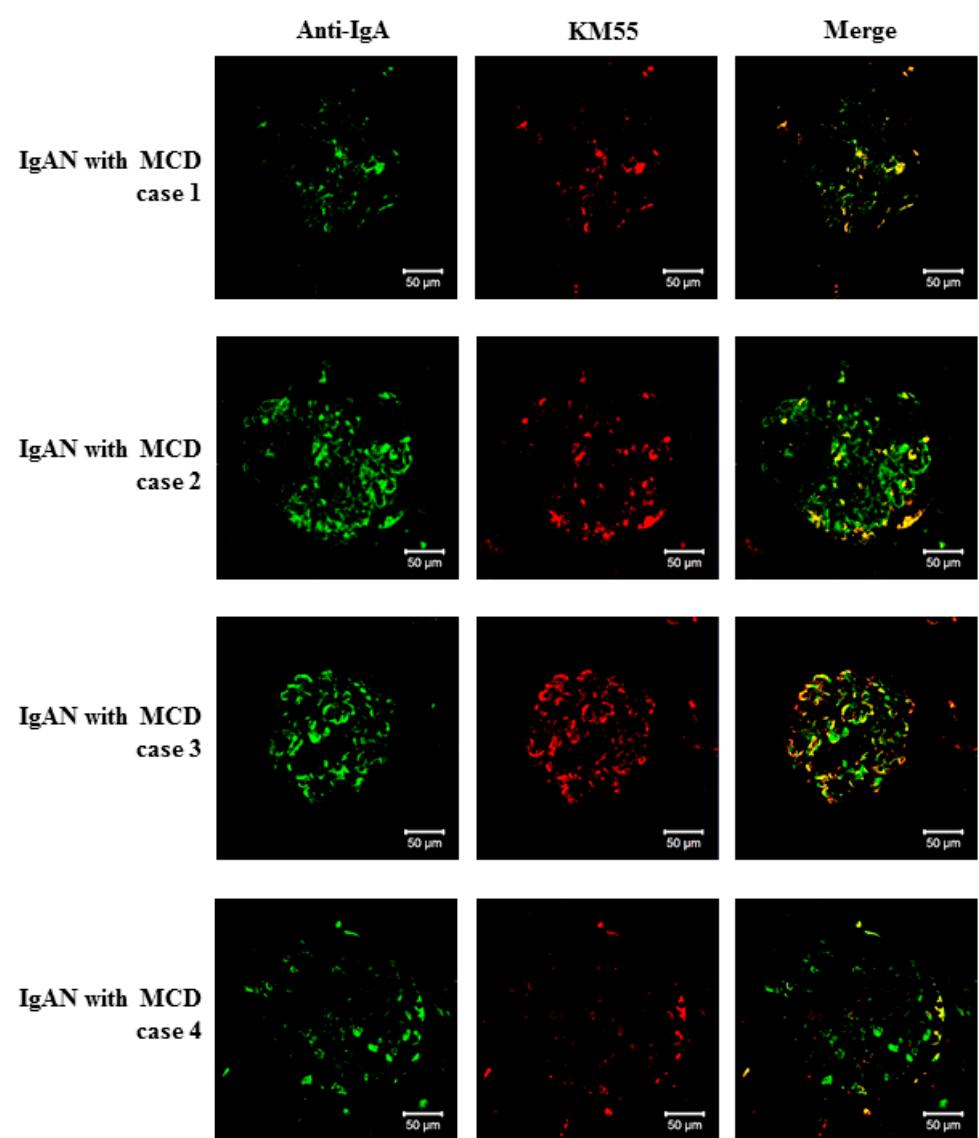
Figure 3. Glomerular deposition of galactose-deficient IgA1 in patients with IgA nephropathy with minimal change disease. Double staining with anti-IgA polyclonal antibody and KM55 monoclonal antibody was performed on kidney specimens from four patients with IgAN-MCD. Four clinical cases are shown. Galactose-deficient IgA1 was localized predominantly in the mesangium with IgA (bars = 50 µ m; original magnification ×200).